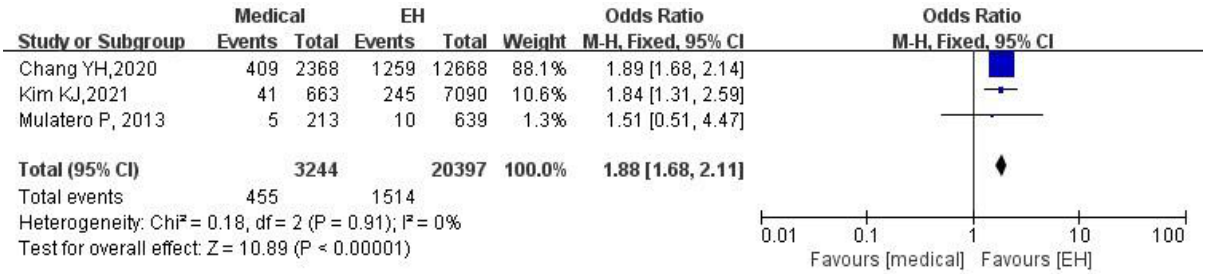
Figure 3. Forest plot of stroke in PA patients receiving medical treatment vs. EH patients. EH, essential hypertension; PA, primary aldosteronism. The blue squares represent the results of individual studies and the black diamonds represent the combined results of total studies in the model.